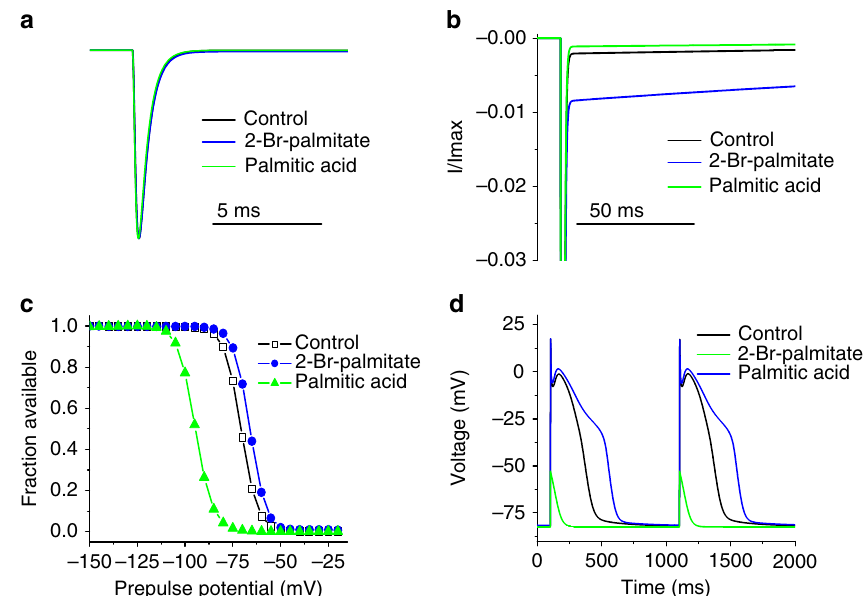
Figure 9 | Computer simulations illustrate the impact of depalmitoylation versus enhanced palmitoylation on cardiomyocyte excitability. ( a ) Comparison of peak simulated control Nav1.5, 2-Br-palmitate and palmitic acid ‘treated’ currents elicited by a step depolarization to (cid:2) 20mV. In the simulation, the kinetics of activation and open-channel inactivation were not altered under the three conditions. The current densities were set to be equal to the peak control current density for comparison of kinetic differences. ( b ) Comparison of persistent (or so-called late) Nav1.5 currents for the three simulated conditions. ( c ) Comparison of voltage dependence of steady-state inactivation for control Nav1.5 (black lines and open symbols), 2-Br-palmitate (green lines and symbols) and palmitic acid (blue lines and symbols) ‘treated’ currents. ( d ) Simulated action potentials from modelled cardiac myocytes are shown. Action potentials were paced at 1Hz in these simulations and the second and third action potentials are shown. The black trace shows action potentials with the control Nav1.5 channels, the green trace with Nav1.5 channels modelled to reflect the changes induced by depalmitoylation with 2-Br-palmitate and the blue trace with Nav1.5 channels modelled to reflect the changes induced by enhanced palmitoylation with palmitic acid